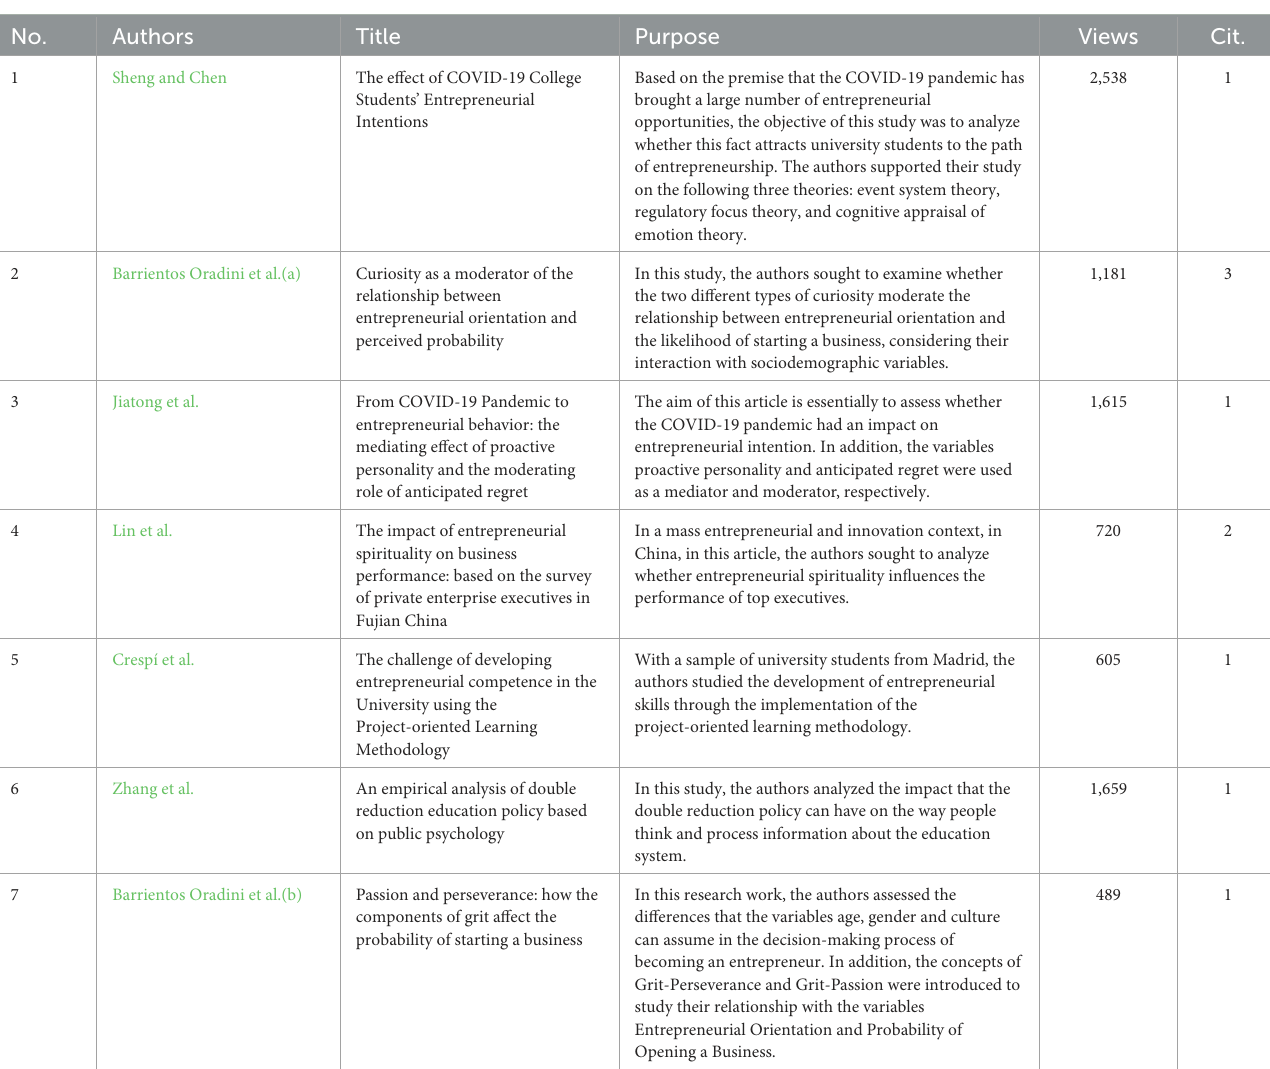
TABLE 1 Summary of